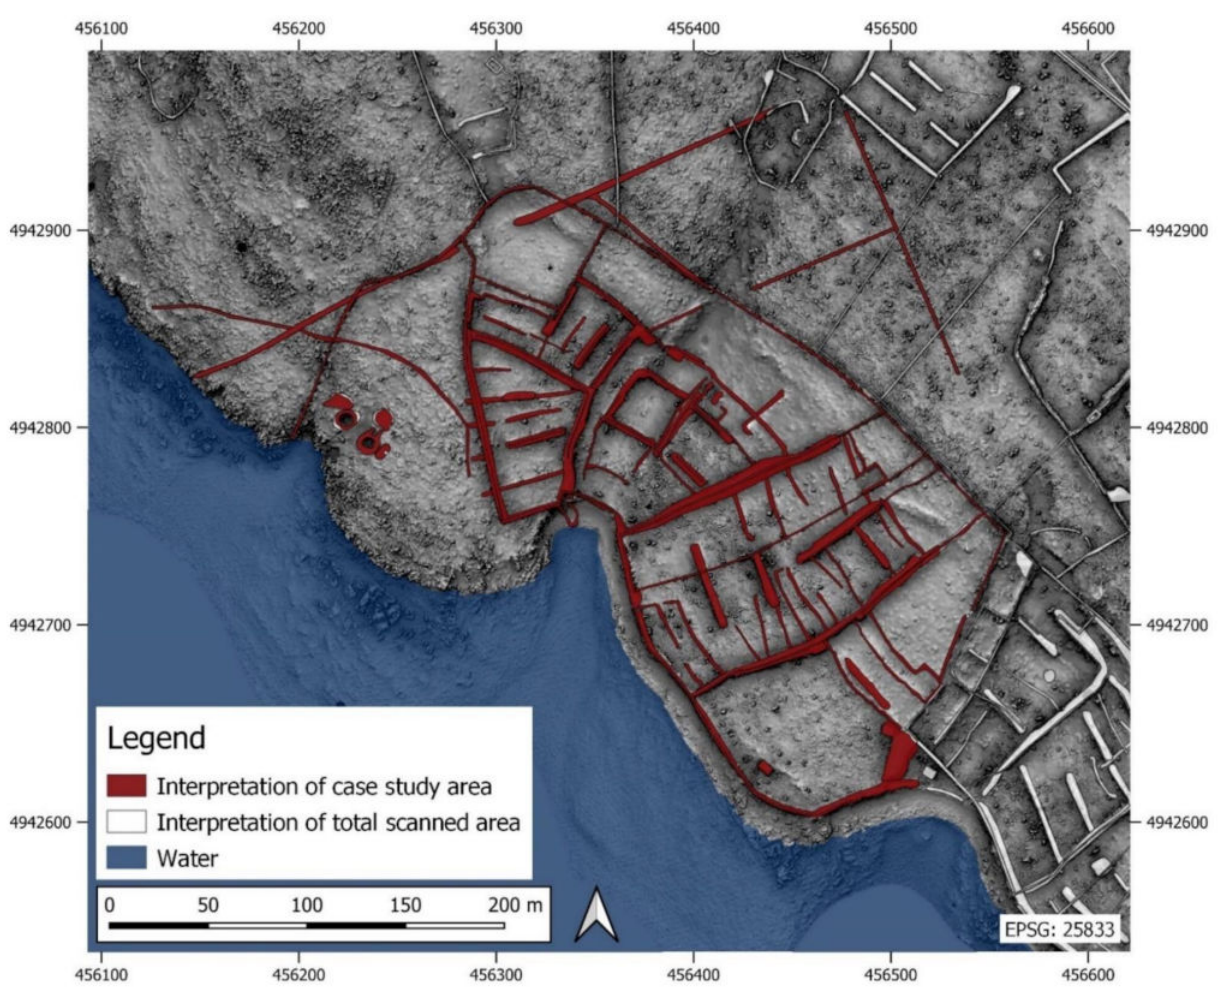
Figure 10. Interpretative mapping of the case study area (red polygons) which is a small part of the archaeological interpretation of the entire laser scan (white polygons). (Visualization: